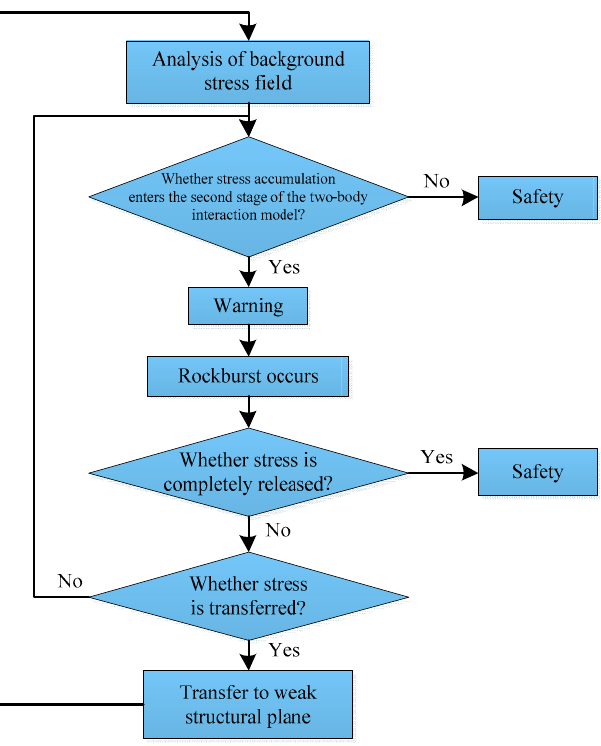
Figure 7. Flowchart of rockburst warning system based on a mechanical model.